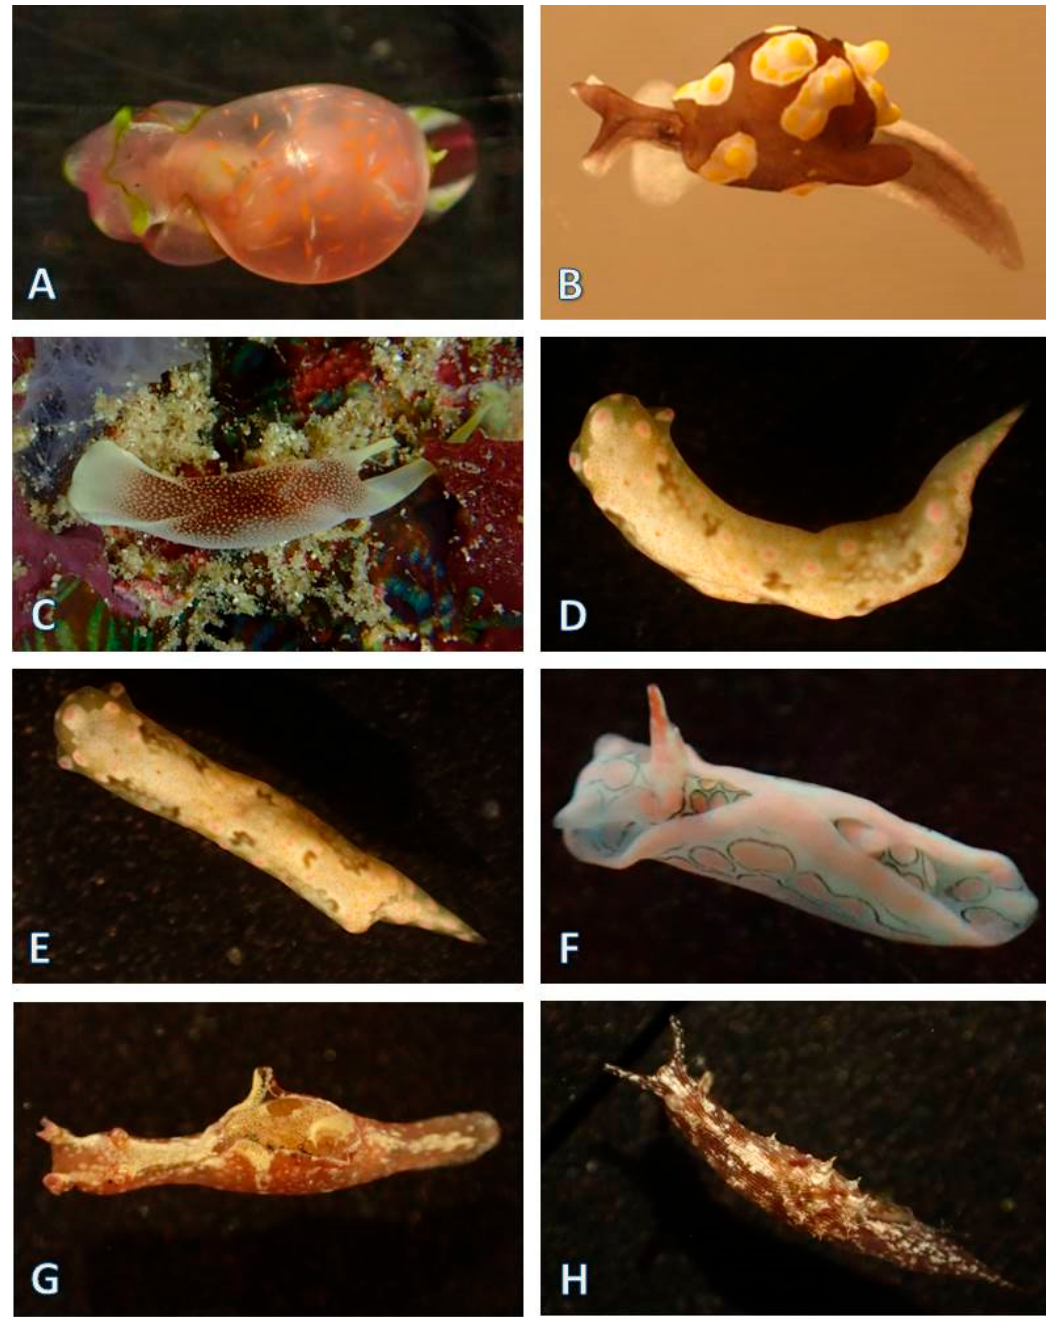
Figure 2. Cephalaspidea and Aplysiida: ( A ) Haminoea sp. ( Haminoea sp. 3 in Gosliner et al. [24]: 34), Hasp18Ba-1; ( B ) Colpodaspis thompsoni , Coth18Ba-2; ( C ) Chelidonura amoena , Cham17Ba-1; ( D , E ) Odontoglaja sp. ( Odontoglaja sp. a), Odsp.a18Ba-1; ( F ) Sagaminopteron psychedelicum , Saps18Ba-2; ( G ) Aplysia cf. nigrocincta , Appa18Ba-1; ( H ) Stylocheilus striatus , Stst18Ba-2. 3.1.2. Aplysiida ( = Anaspidea) (Two Species in Two Genera Belonging to One